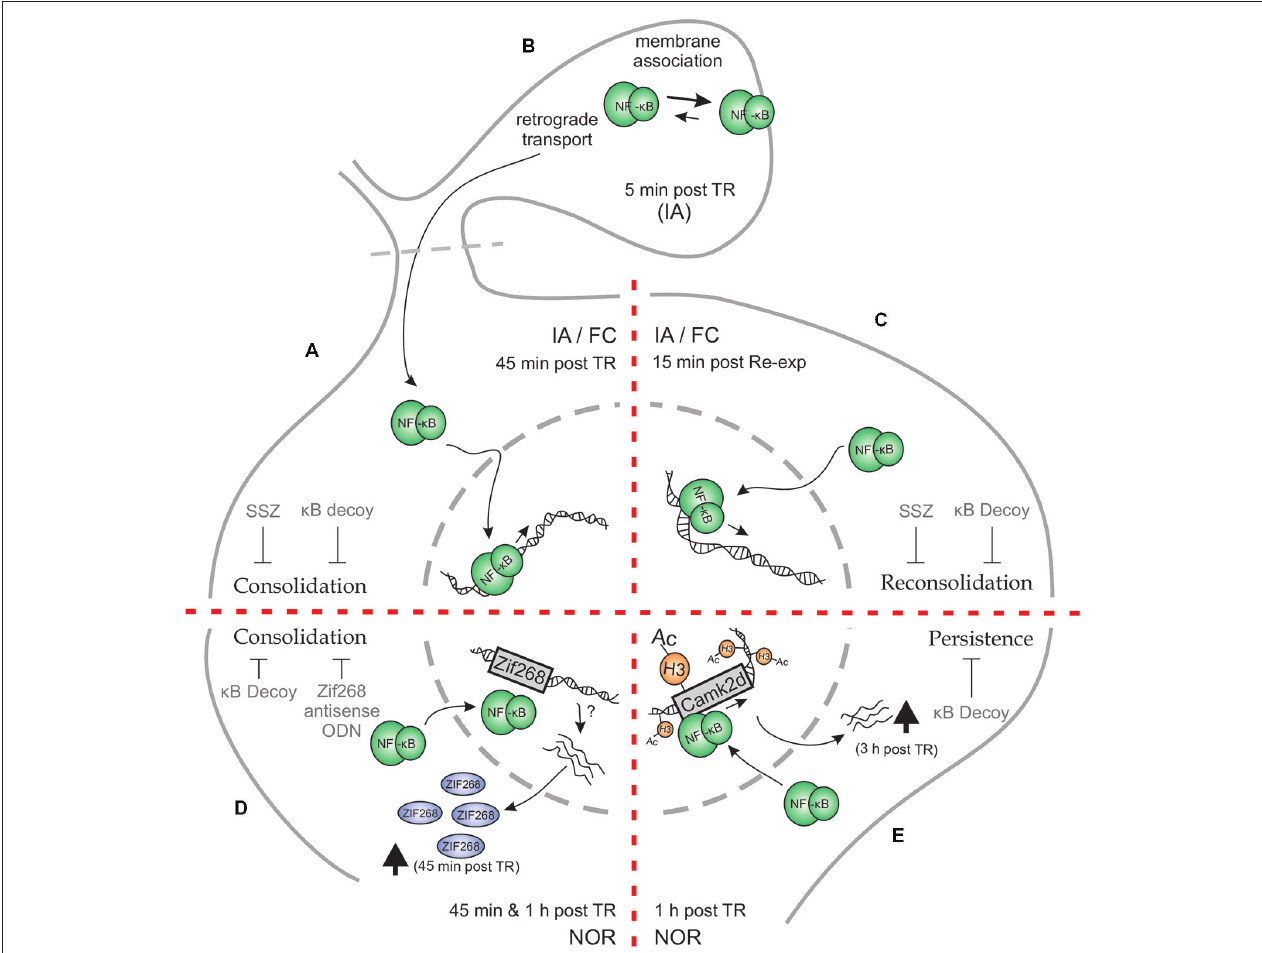
FIGURE 1 | Schematic representation of Hippocampal NF- κ B involvement in different phases of memory for different memory tasks. (A–C) Inhibitory Avoidance (IA) and Fear Conditioning (FC). (A) Both in IA and in FC, training (TR) induces an increase in hippocampal NF- κ B activity 45 min after TR. Administration of NF- κ B inhibitory drugs— κ B decoy or sulfasalazine (SSZ)—in hippocampus disrupts long-term memory (LTM) consolidation. (B) When hippocampal synaptosmal preparations were analyzed, a membrane association of NF- κ B was observed 5 min post TR in IA paradigm, postulating that synaptic NF- κ B not only acts as